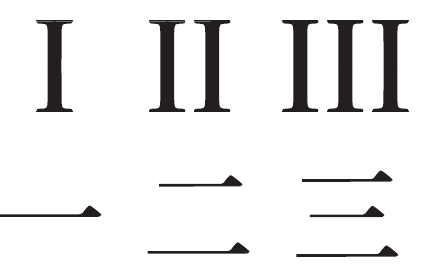
Figure 1. Numbers represented in the unary